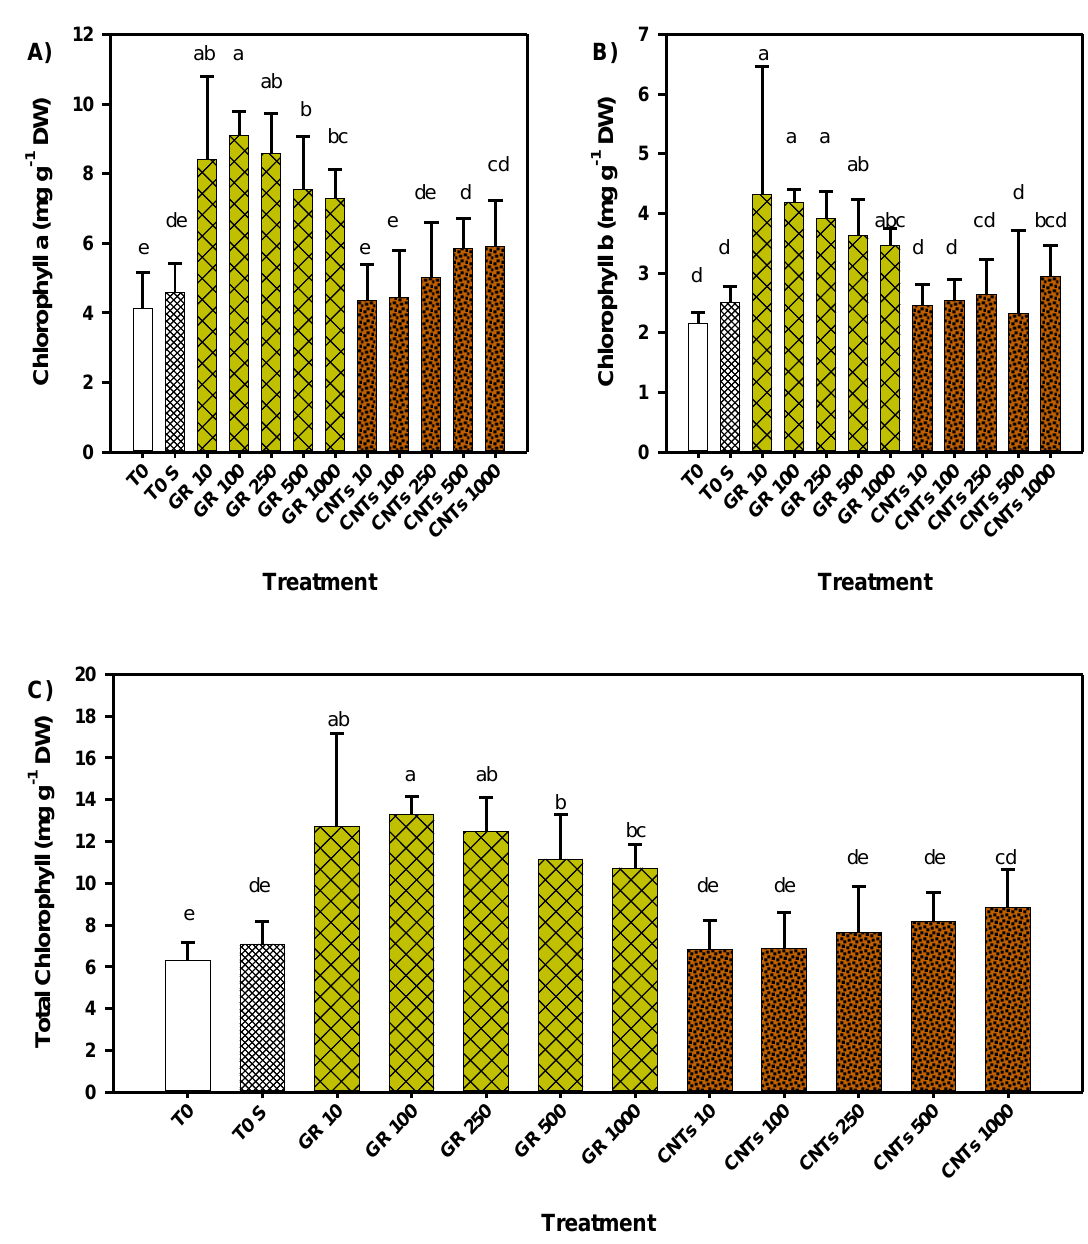
Figure 3. The contents of chlorophylls in the leaves of tomato seedlings treated with carbon nanomaterials. Each data point is the average of five replicates ± standard error. Different letters indicate significant differences between treatments according to Fisher’s least significant difference test ( p ≤ 0.05). T0: absolute control. T0 S: sonicated control. GR: graphene. CNTs: carbon nanotubes. DW: dry weight.